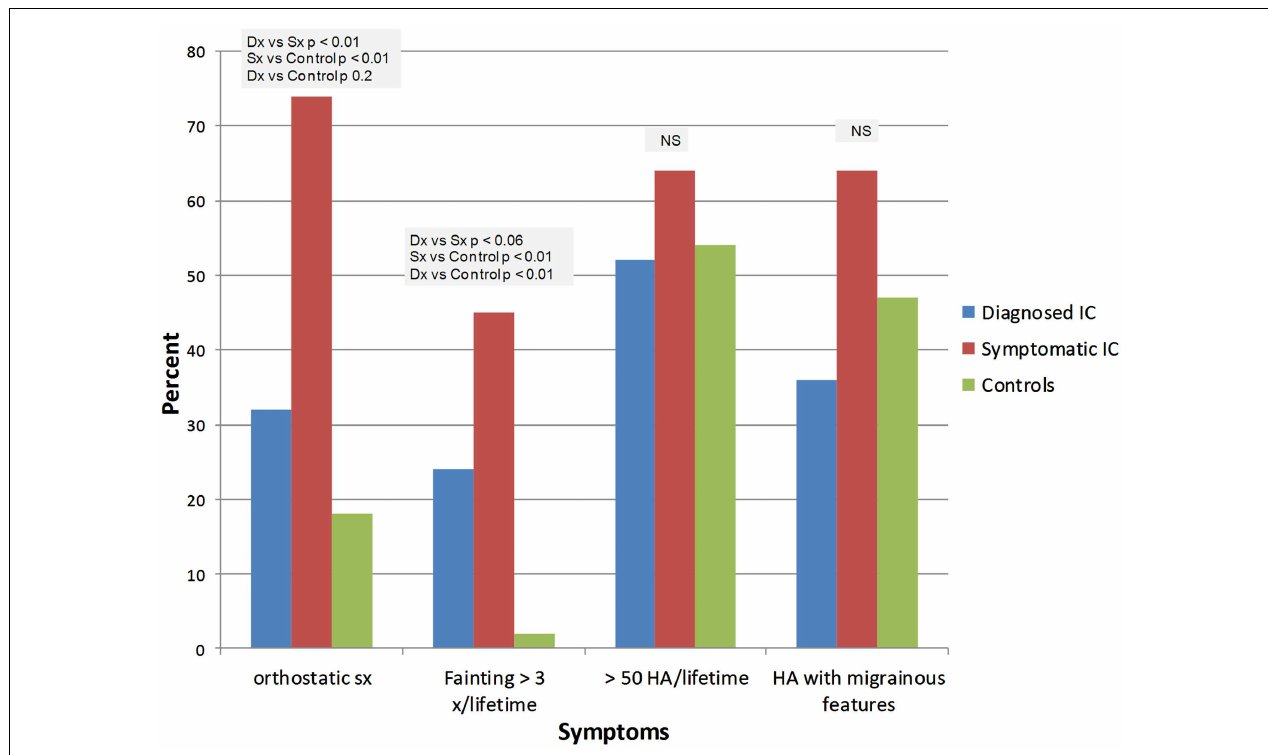
FIGURE 4 | Summary of orthostatic symptoms and headaches. Dx: corresponds to IC/BPS diagnosed by a physician (diagnosed IC); Sx corresponds to subjects who have symptoms of IC/BPS based on NIDDK criteria (symptomatic